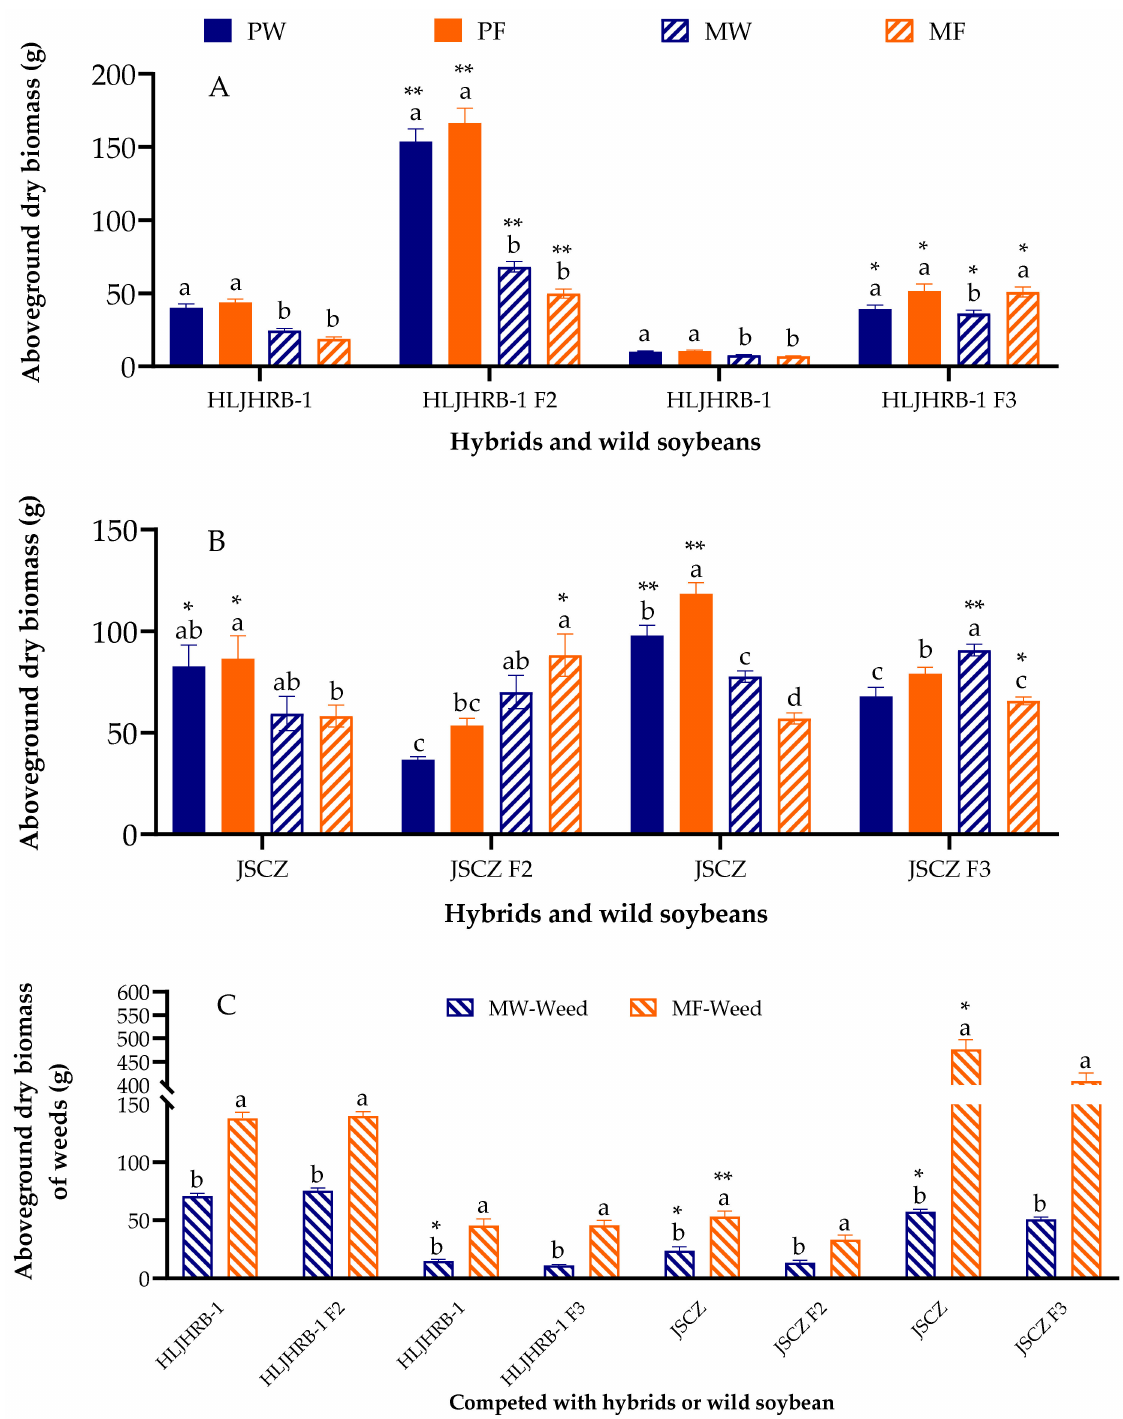
Figure 4. Aboveground dry biomass of hybrids, wild soybeans ( A , B ), and weeds ( C ) under four plant- ing conditions. Note: * and ** indicate significant difference ( p < 0.05) and extremely significant difference ( p < 0.01) of the same trait between hybrids and their wild soybeans. Different lowercase letters indicate significant difference ( p < 0.05) of hybrids or wild soybeans among four planting